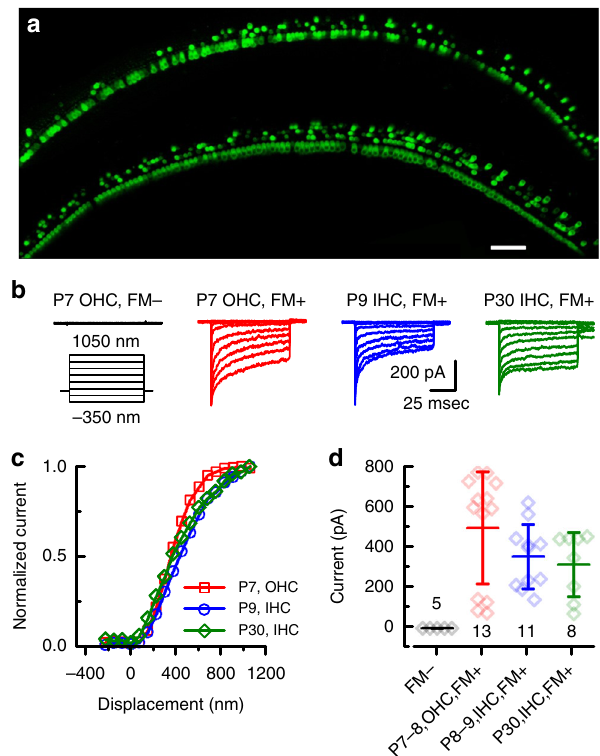
Fig. 1 sAAV- Tmc1 restores sensory transduction in Tmc1 Δ / Δ ;Tmc2 Δ / Δ IHCs and OHCs. a Confocal images of two apical sections excised from P7 Tmc1 Δ / Δ ;Tmc2 Δ / Δ mouse cochleas after injection of sAAV- Tmc1 through the RWM at P1. The tissue was cultured for 7 days and perfused with 5 µ M FM1-43 for 10 s followed by 3 full bath exchanges to washout excess dye. The tissue was then mounted and imaged for FM1-43 uptake (green) in IHCs and OHCs. Scale bar = 25 µ m. b Representative families of sensory transduction currents evoked by mechanical displacement of hair bundles (protocol shown below) recorded from P7 apical OHCs of Tmc1 Δ / Δ ;Tmc2 Δ / Δ mice injected with sAAV- Tmc1 that were FM1-43-negative (left) or FM1- 43-positive (second from left). FM1-43-positive currents were also recorded from P9 IHCs (second from right) and P30 IHCs (right) of Tmc1 Δ / Δ ;Tmc2 Δ / Δ mice injected with sAAV- Tmc1 . c Stimulus-response curves from the currents shown in b . d Mean± S.D. peak sensory transduction current amplitudes from apical FM1-43-negative and FM1-43- positive IHCs and OHCs from Tmc1 Δ / Δ ;Tmc2 Δ / Δ mice injected with sAAV- Tmc1 at time points as indicated. n = number of hair cells relationships (Fig. 1c), and sensory transduction current ampli- tudes (Fig. 1d) that were not signi fi cantly different ( p = 0.45, one- way ANOVA at P30 + IHCs) from wild-type hair cells and those of wild-type cells transduced with sAAV- Cmv -GFP 17 . The hair cell physiology data together with the FM1-43 data indicate that